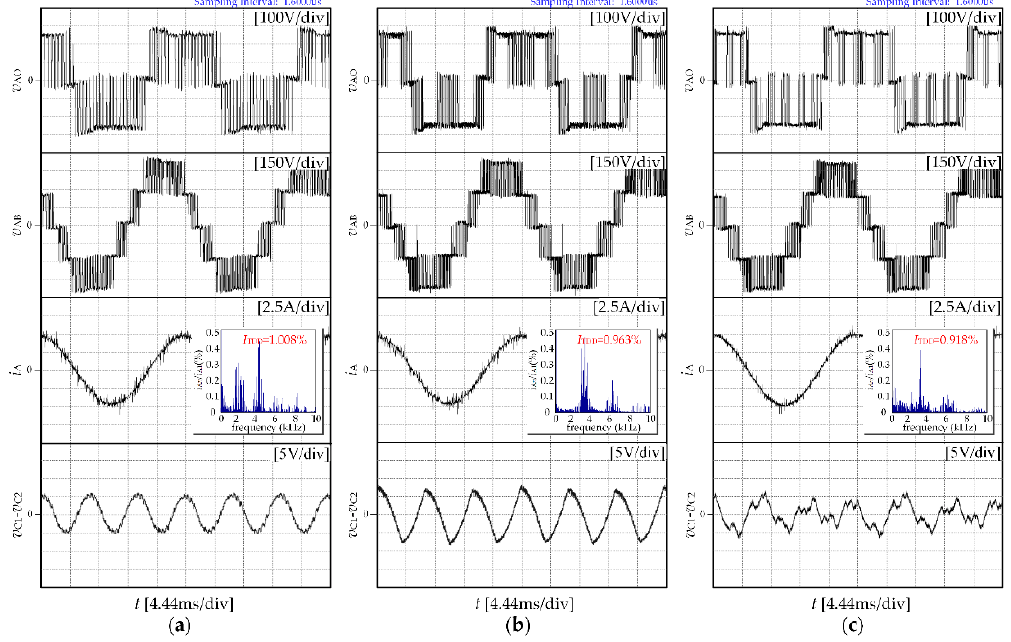
Figure 10. Experimental results for CPWM, DPWM3, and the proposed strategy when m = 0.9: ( a ) CPWM; ( b ) DPWM3; ( c ) the proposed strategy.